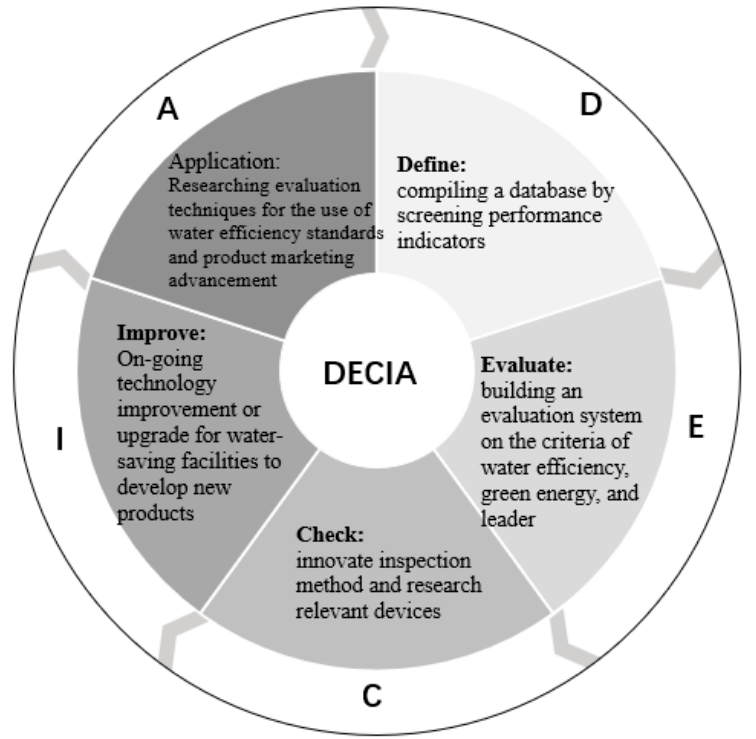
Figure 1. Schematic diagram of DECIA model.